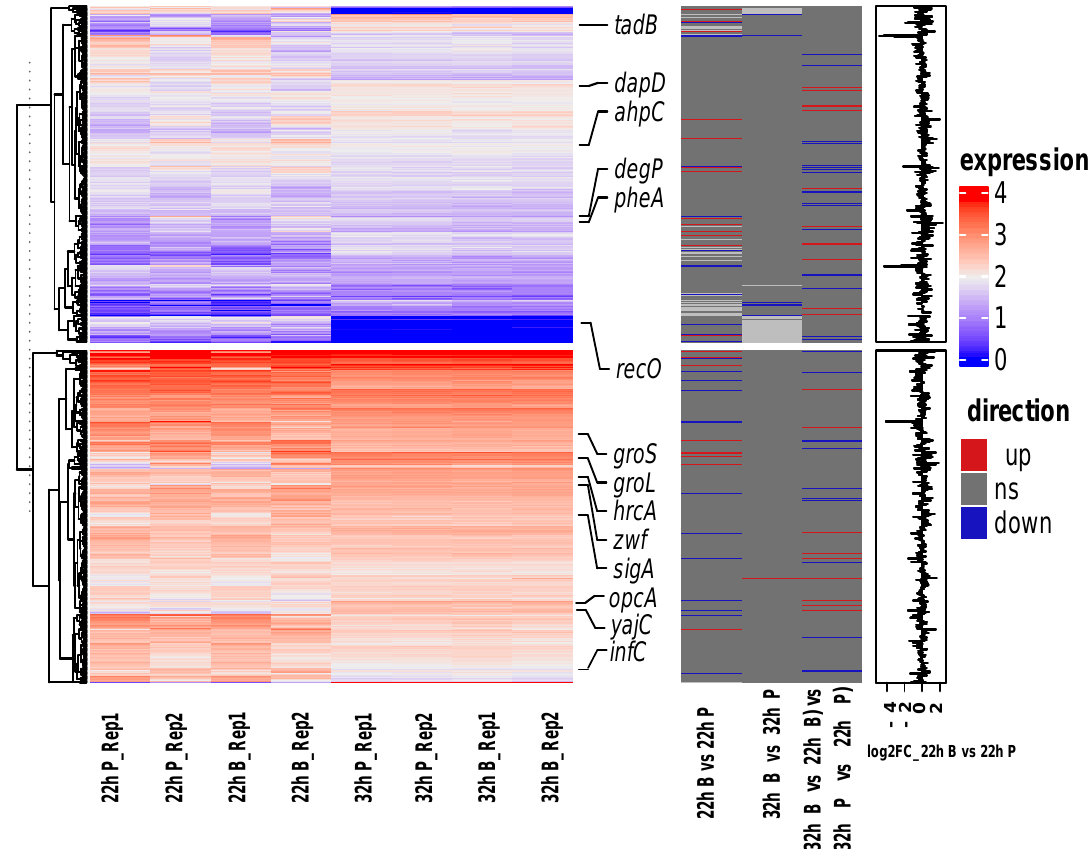
Figure 4. Gene expression heatmap of B. bifidum FHB150. The left heat map shows the gene expression levels in different samples. Red indicates a higher gene expression level, and blue indicates a lower gene expression level. The color from red to blue indicates log10 (FPKM +1) from high to low. The middle heat map shows the three directions of genes, upregulated, downregulated or ns (no significance). FPKM: fragments per kilobase of exon per million mapped fragments. The right bar graph is the differential expression log2 FC of genes in 22 h B vs. 22 h P. FC: fold